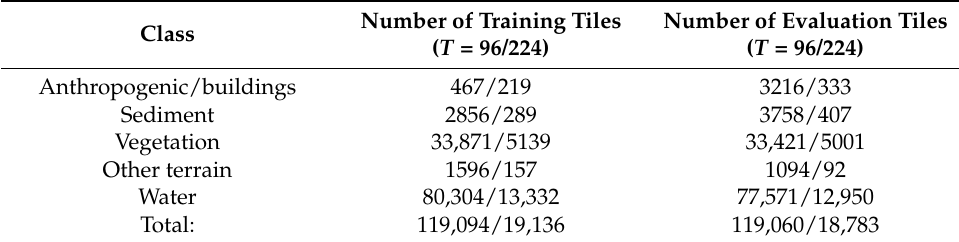
Table A2. Classes and number of tiles used for the Lake Ontario dataset.